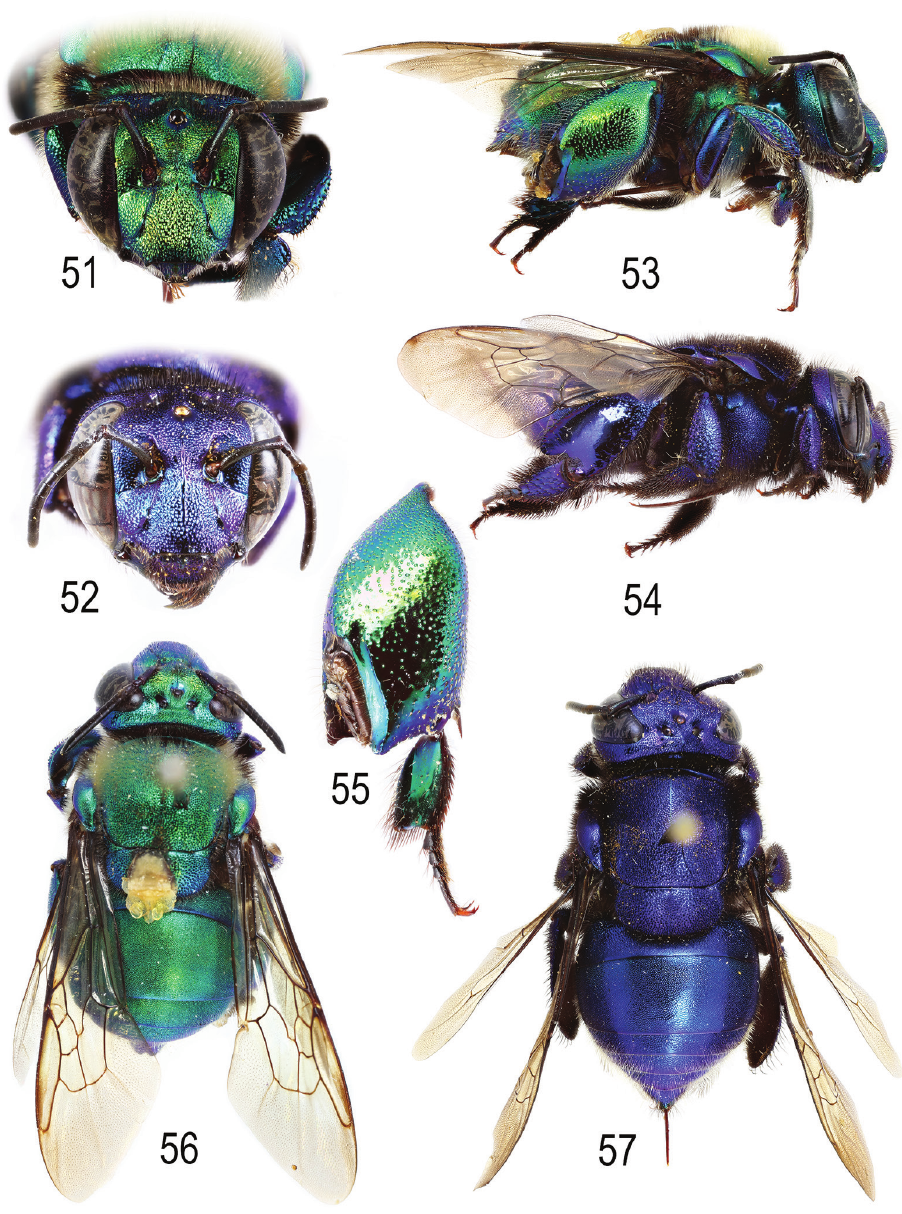
Figures 51–57. Male holotype (except paratype in Fig. 55, EMEC 1069134) and female paratype (Mexico: Guerrero, EMEC 1069136) of E. oliveri . 51, 52 Facial view 53, 54 Lateral habitus 55 Outer view of hind leg 56, 57 Dorsal habitus 51, 53, 55, 56 Male 52, 54, 57